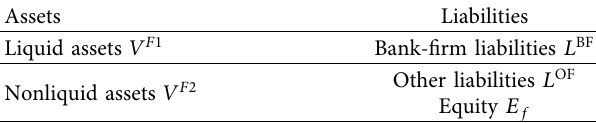
Table 2: Simplified balance sheet of a